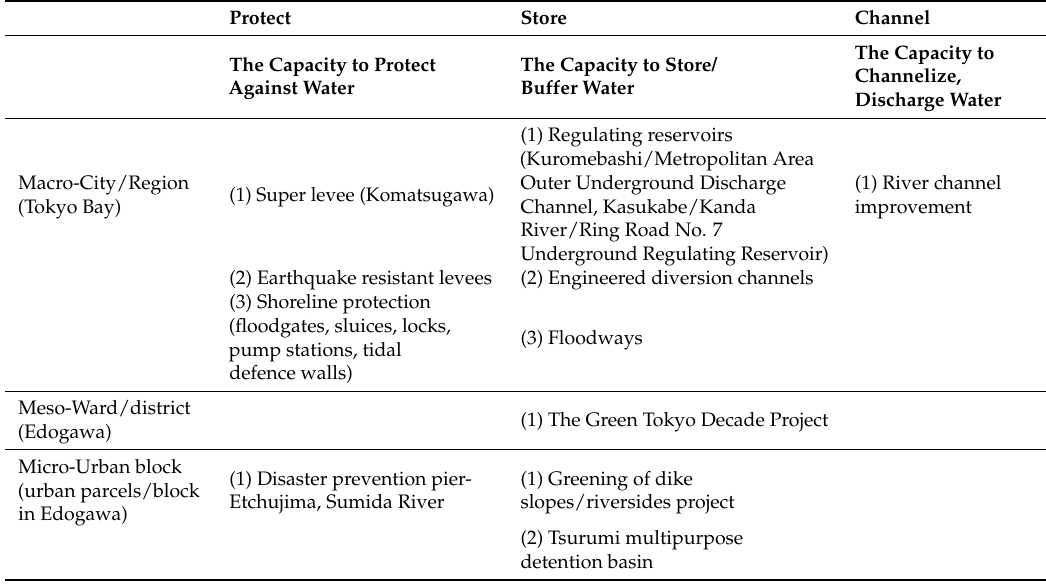
Table 1. Flood defense projects catalogued based on function and scale [4–9,19–22].